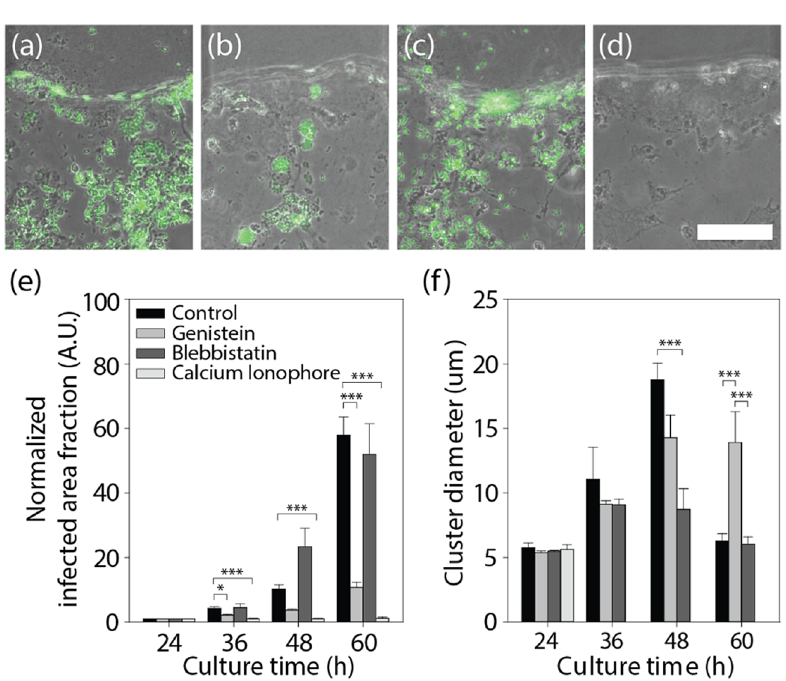
Figure 6. Chemical treatment of tachyzoites infecting the EC monolayer. ( a–d ) Images after 60 h of processing each chemical; ( a ) control, ( b ) Genistein, ( c ) Blebbistatin, and ( d ) calcium ionophore. ( e ) Proliferation of tachyzoites in the EC monolayer, and ( f ) their cluster size. Scale bar indicates 100 μm. Statistical significance was analyzed by one-way ANOVA with Holm-Sidak method and is indicated by asterisks as follows: *P < 0.05, **P < 0.01, ***P <